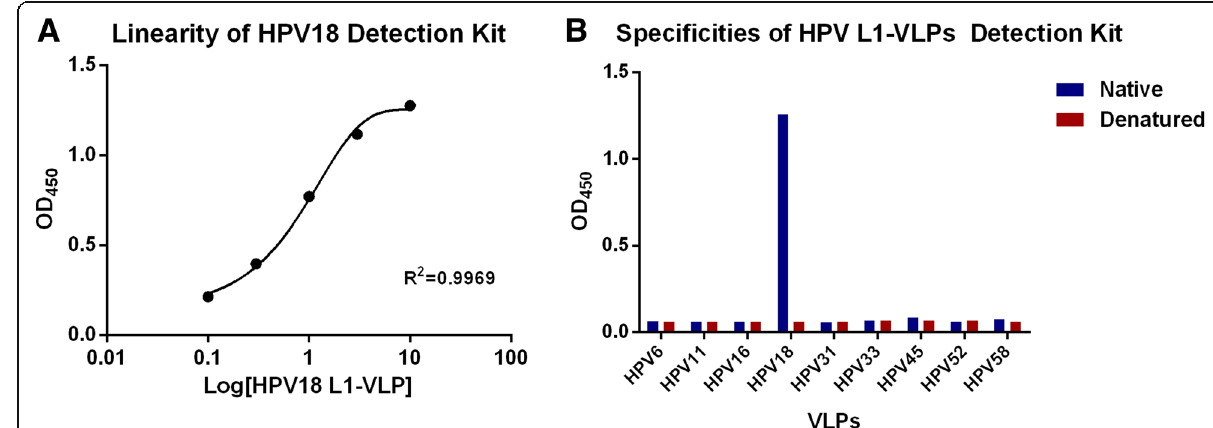
Fig. 4 Characterization of the HPV18 L1-VLP Detection Kit developed in this study. a The linearity of the HPV18 L1-VLP Detection Kit. Each well was coated with 10 μ g/ml of mAb 4C2, blocked with 3% BSA-PBST, and air-dried. Different concentrations (0.1, 0.3, 1.3, and 10 μ g/ml) of the HPV18 L1-VLP standards were diluted in 3% BSA-PBST and tested in triplicate. The positive control was defined as being the mean of greater than 2.1times the negative control. The standard curve was sigmoidally fitted with 4 parameters; x axis is the logarithm of HPV18 L1-VLP concentrations; y axis was the optical density at 450 nm (OD 450 ); b The specificities for native and denatured HPV L1-VLPs of the Detection Kit. The OD 450 values of all samples tested were plotted against various genotypes of HPV L1-VLPs (both native and denatured). The bar graph was prepared using Prism GraphPad 6.0. All L1-VLPs samples were adjusted to an initial concentration of 30 μ g/ml (100 μ l per well). All of the values were the average of multiple